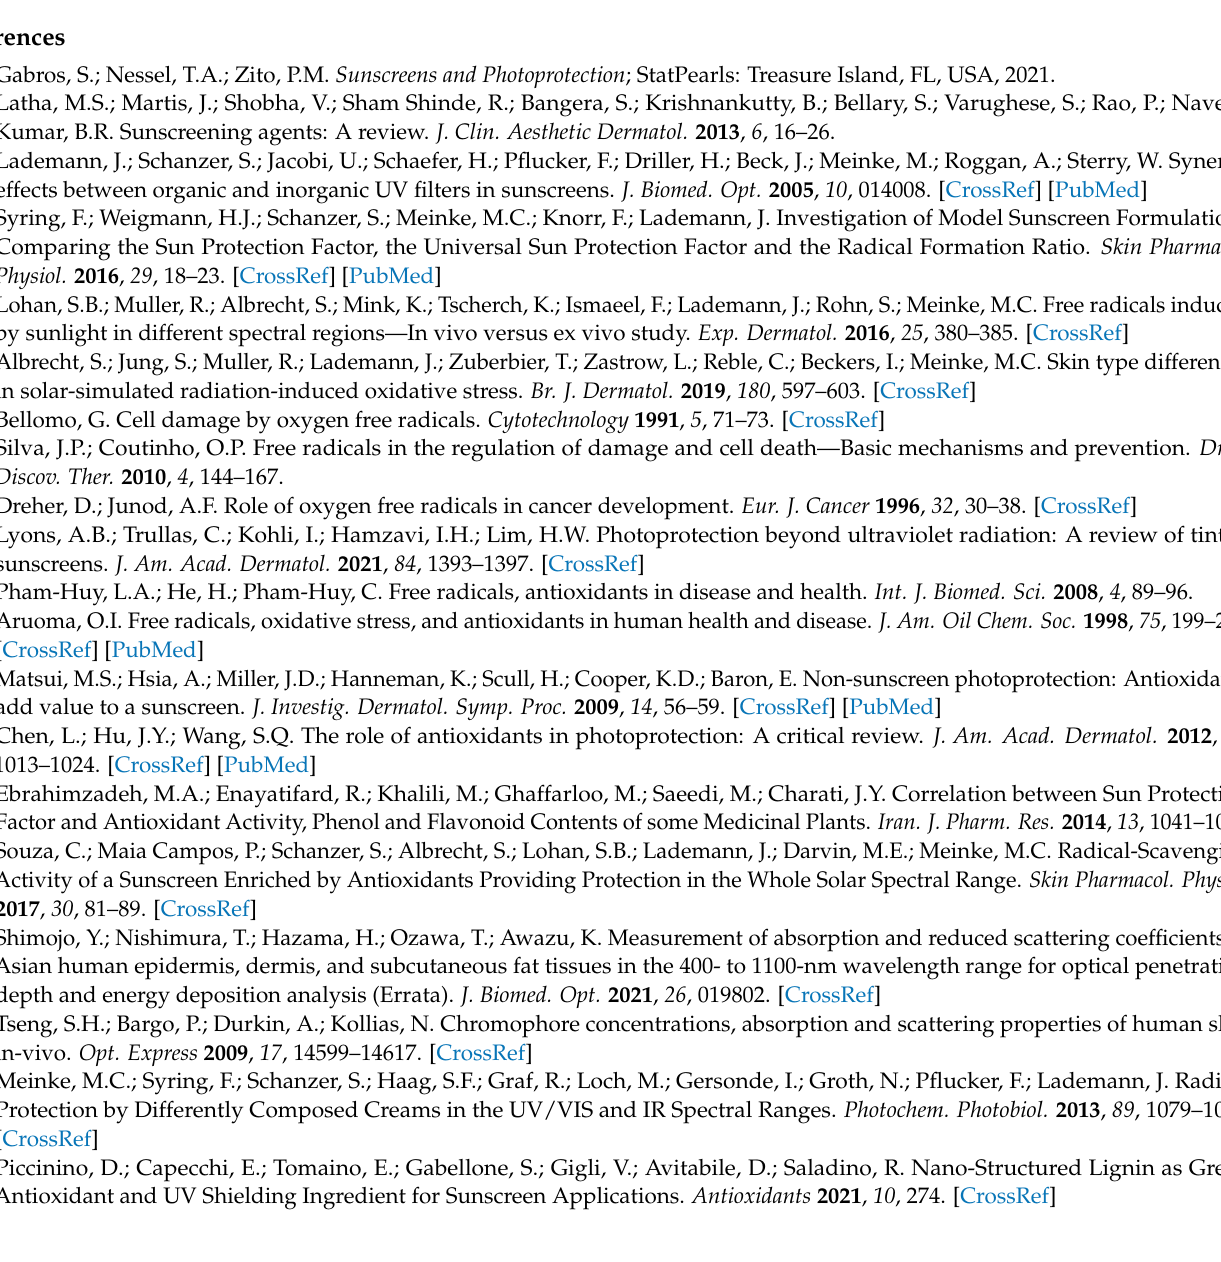
Figure A1. Photo of the used cream formulations.